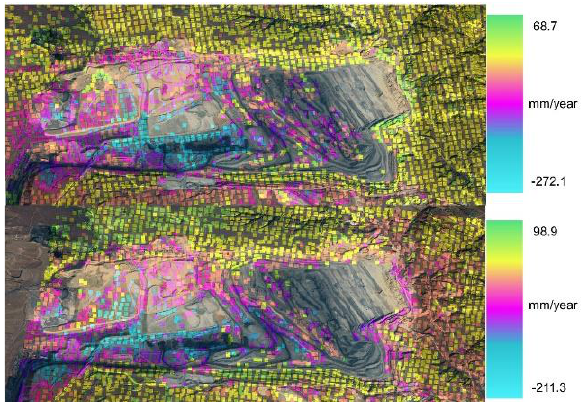
Figure4. Annual average LOS displacement velocity